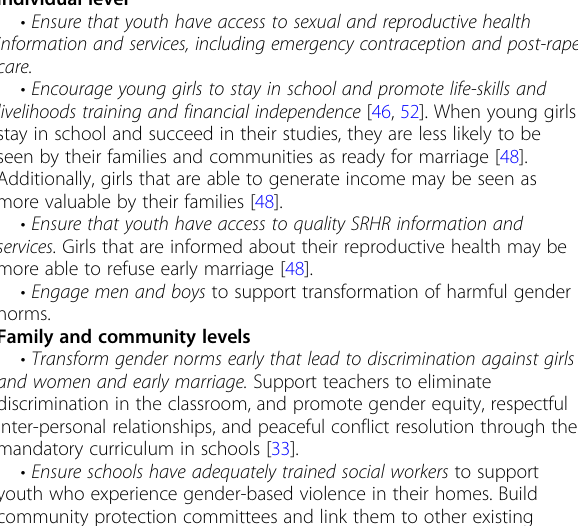
Table 3 Summary of Key Lessons Learned and Opportunities for Intervention to improve Sexual and Gender-based Violence and Early Marriage Among Youth in